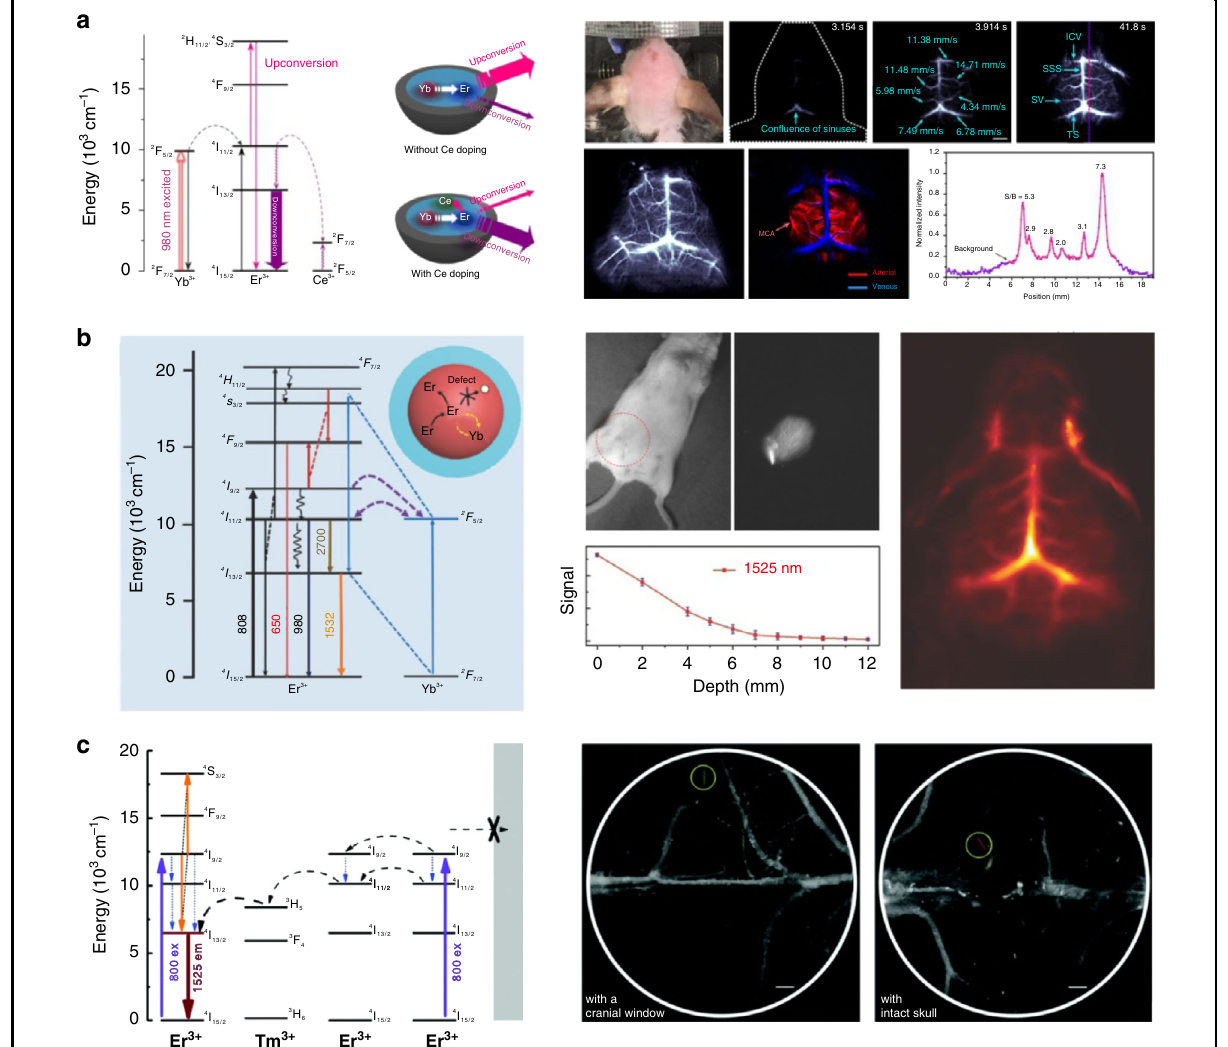
Fig. 3 Intravital fl uorescence imaging of cerebrovascular structure by using different RENPs. a Schematic diagram of the energy-transfer process of Er-based RENPs doped with and without Ce 3 + ions (left). Fluorescence images of cerebral vessels with Ce 3 + doped Er-RENPs (right). Reprinted with permission from ref. 53 . Copyright 2017 Yeteng Zhong et al. b Energy level diagrams of the self-sensitized nanoparticles (left). Intravital fl uorescence imaging of cerebral vessels after injection of NaErF 3 + @NaLuF 56 . 4 :Yb 4 core/shell nanocrystals (right). Reprinted with permission from ref. Copyright 2018 Wiley-VCH GmbH. c Energy-transfer mechanisms of the NaErF 4 :Tm 3 + @NaLuF 4 core-shell nanoparticles (left). The cerebrovascular images of the mice with a cranial window and with an intact skull under NIR excitation (right). Reprinted with permission from ref. 59 . Copyright 2021 The Royal Society of